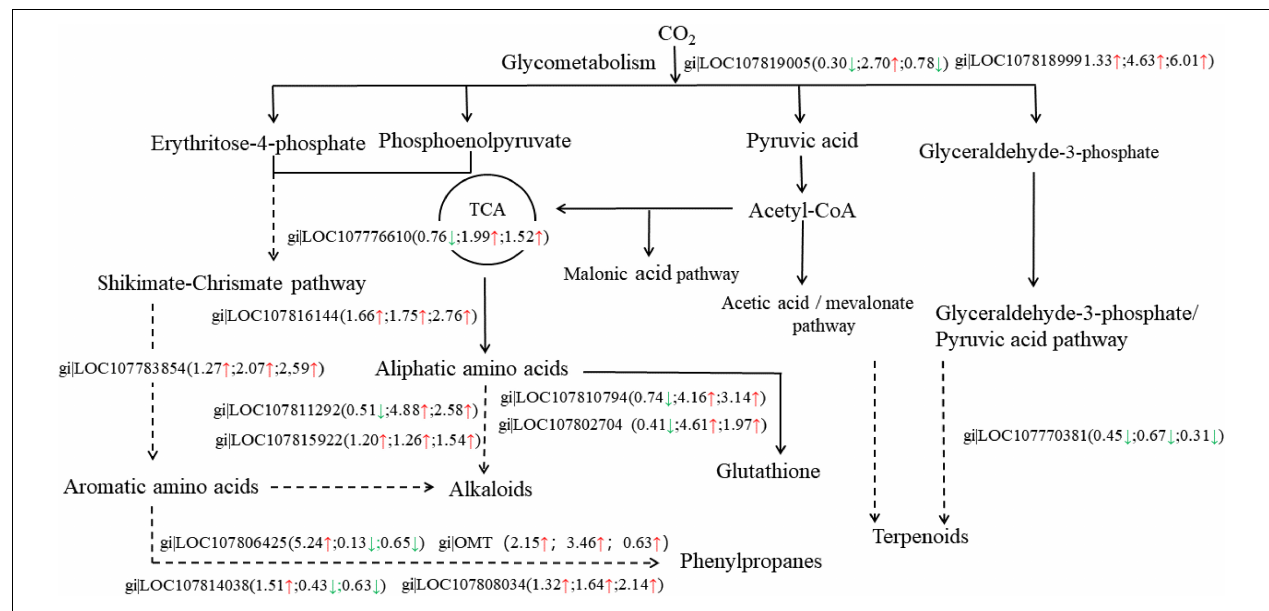
FIGURE 7 | The Kyoto Encyclopedia of Genes and Genomes (KEGG) pathway of DAPs related to defense mechanisms. Upregulated proteins are marked with upward red arrows and down-regulated proteins with downward green arrows; the numbers represent the fold change. The left arrows or numbers represent the differential proteins in LS vs. PS, the middle arrows or numbers represent the differences in proteins in LS vs. RS, the right arrows or numbers represent the differences in proteins in PS vs.